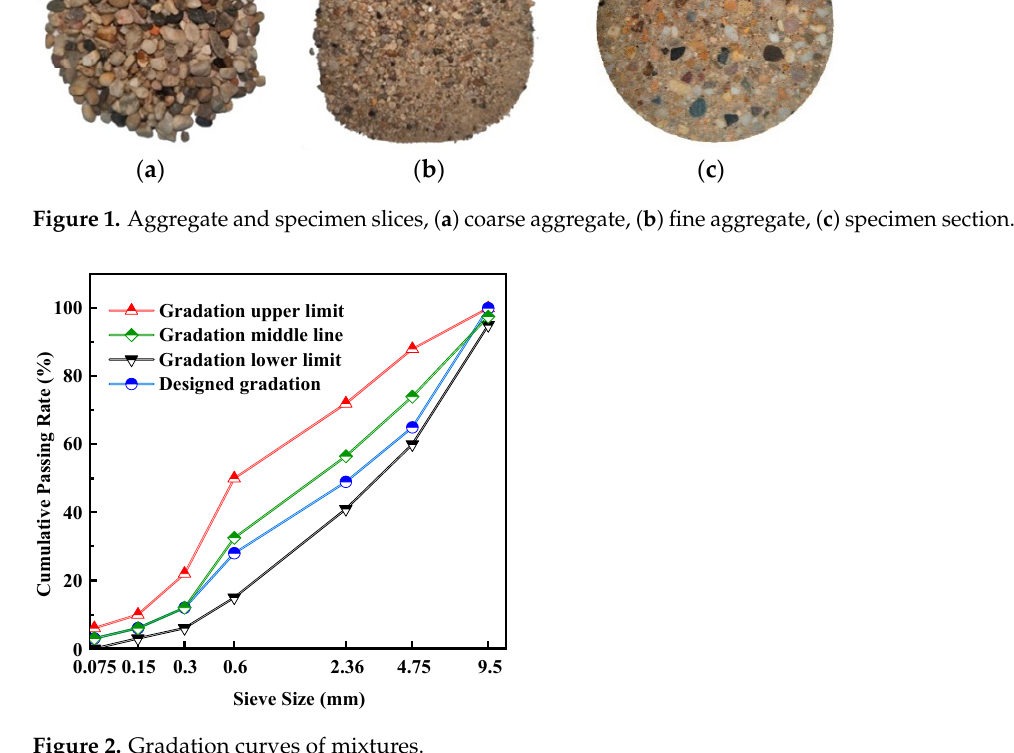
Figure 1. Aggregate and specimen slices, ( a ) coarse aggregate, ( b ) fine aggregate, ( c ) specimen sec- tion.